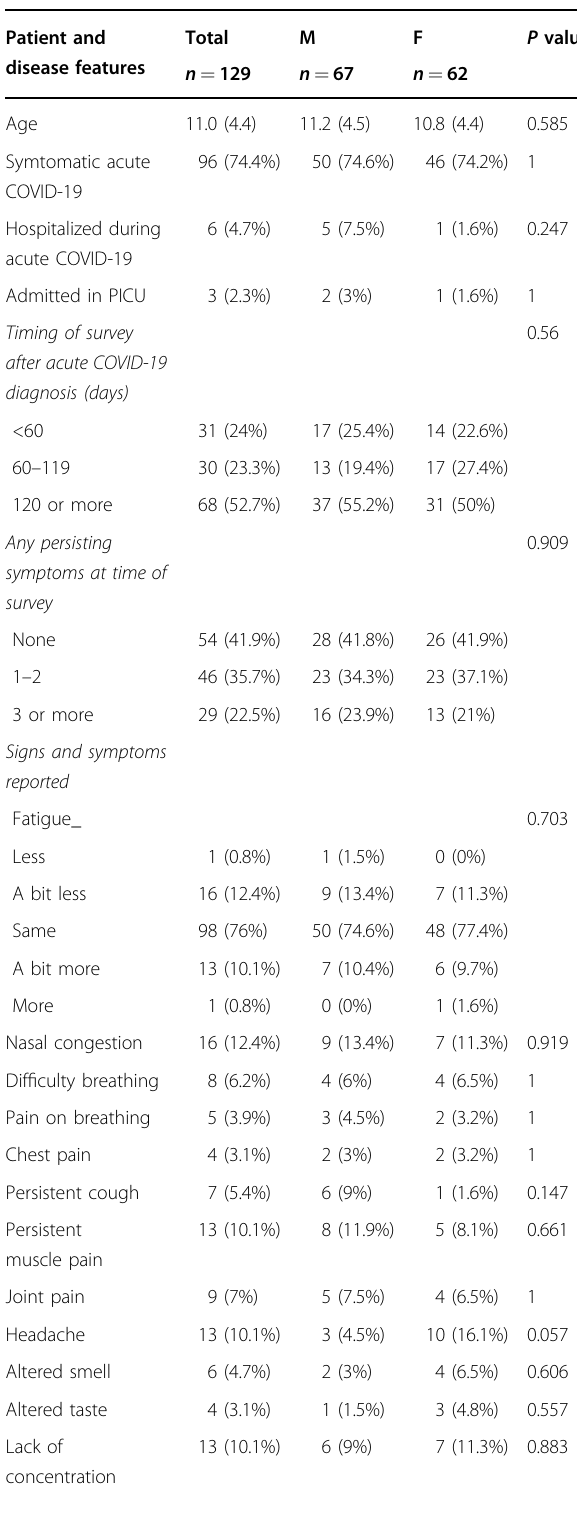
Table 1 Details of persisting symptoms of children with COVID-19, according to